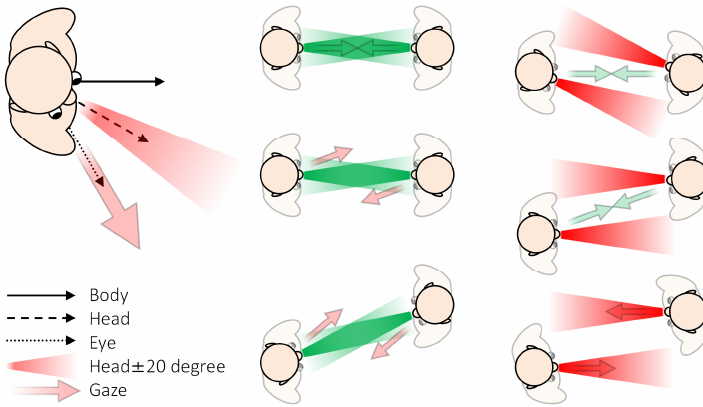
Figure 3. Body orientation, head orientation, eye position, and gaze position ( Left ); illustration of face-to-face behavior ( Middle ); and not face-to-face behavior ( Right ), from our definition. Interpersonal distance is a subjective measure defining a human’s personal space. According to Hall, who defined proxemics, this invisible range is one of the key dimensions of society [10]. Kendon suggested the concept of